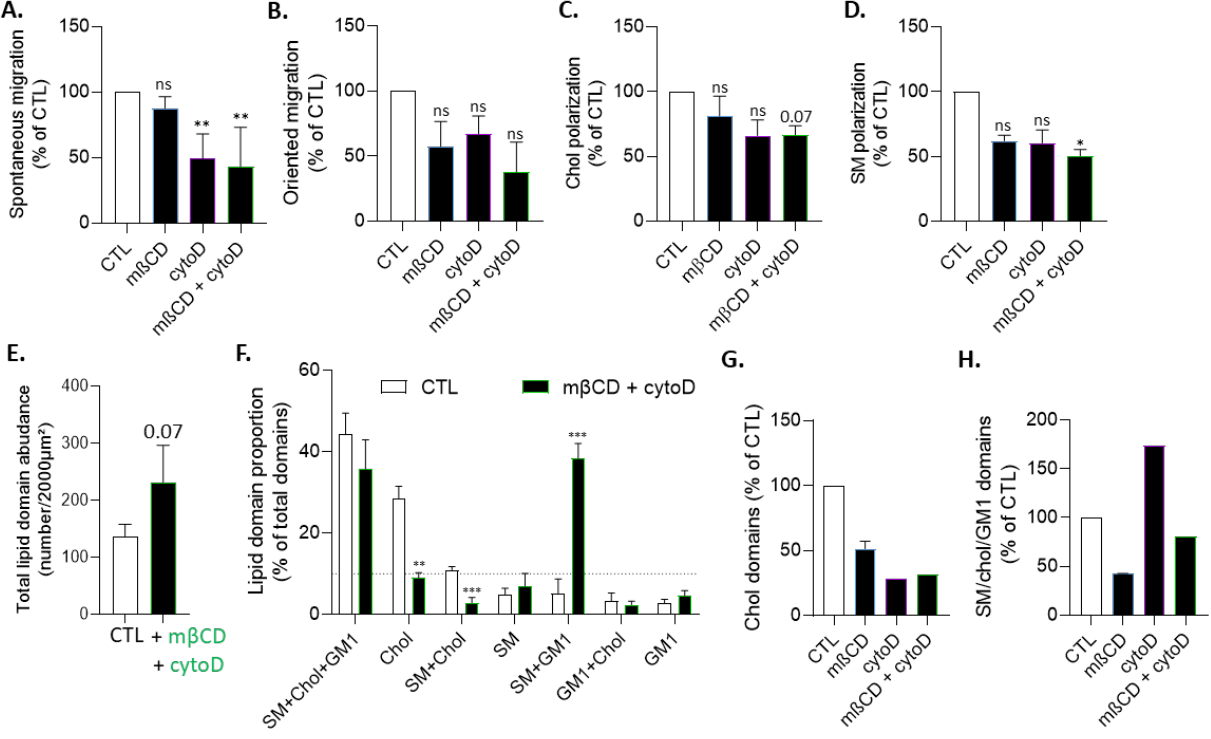
Figure 7. The effects of cholesterol depletion on chol-enriched domain proportion at resting state, cholesterol and sphingomyelin polarization, and migration extent are largely abrogated in actin- depolymerized myoblasts. Cells were left untreated or pretreated with 5 mM m β CD, 0.5 µM cytoD or a combination of both treatments. ( A , B ) The quantification of cell migration in Ibidi chambers (A) or in transwells towards IGF-1 ( B ). The data are expressed as means ± SD ( n = 3 – 7 independent experiments). Friedman test followed by Dunn’s multiple comparisons test. ( C , D ) Cells were single- labeled for chol (theta) or SM (lysenin) then analyzed for lipid polarization. The data are expressed as the MGV at the front vs. the MGV at the rear then in % of control (means ± SD, n = 3 independent experiments). Friedman test followed by Dunn’s multiple comparisons test. ( E , F ) Cells were simul- taneously triple-labeled for SM, chol, and GM1 (BODIPY-SM, theta, CTxB), then quantified for lipid domain abundance relative to cell surface ( E ) and proportion ( F ), as in Figure 2. Dotted line indicates the threshold for lipid domain acknowledgement. The data are expressed as means ± SD ( n = 4 – 6 cells from 1 experiment, 10 – 15 profiles drawn and 150 – 200 domains analyzed). Wilcoxon signed-